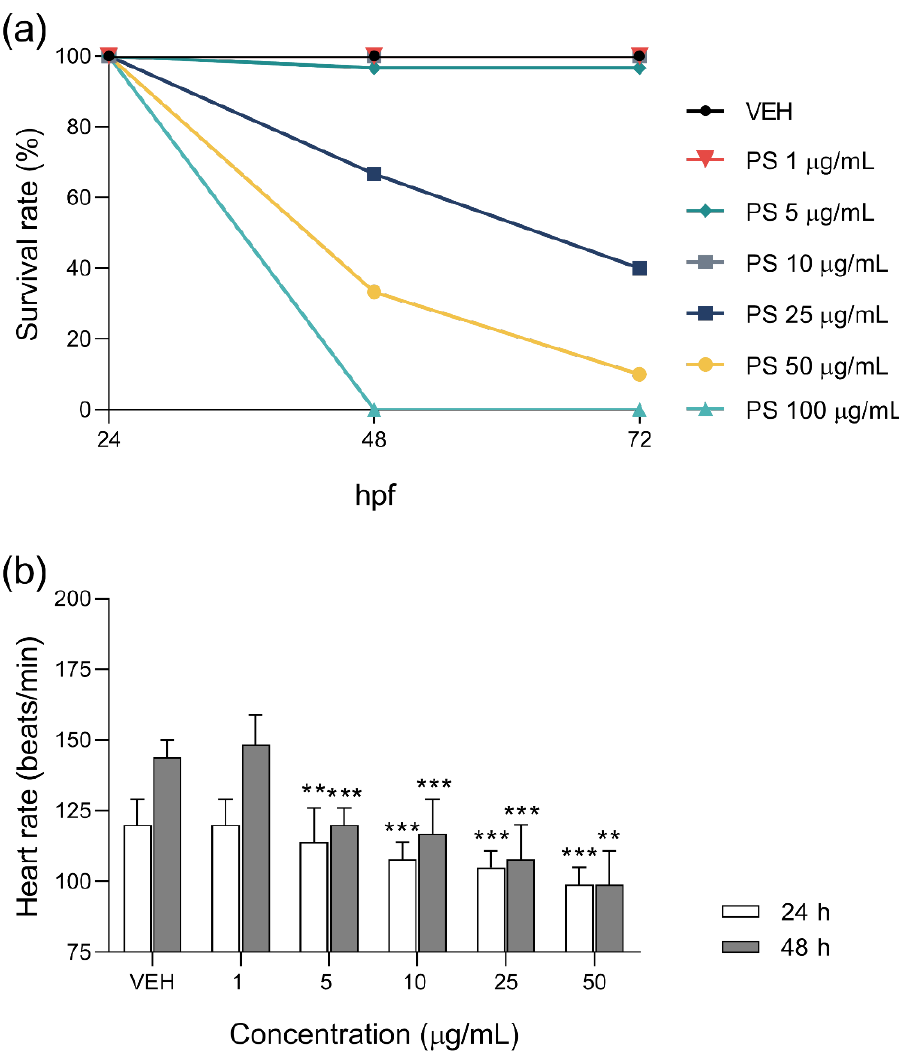
Figure 4. Survival ( a ) and heart ( b ) rates of zebrafish embryos at 24 h post–fertilization (hpf) exposed for 24 and 48 h to vehicle (VEH) and protamine sulfate (PS) concentrations. Data are shown as medians with ranges. Note: ** p < 0.01, *** p < 0.001 vs. VEH within the group, Kruskal–